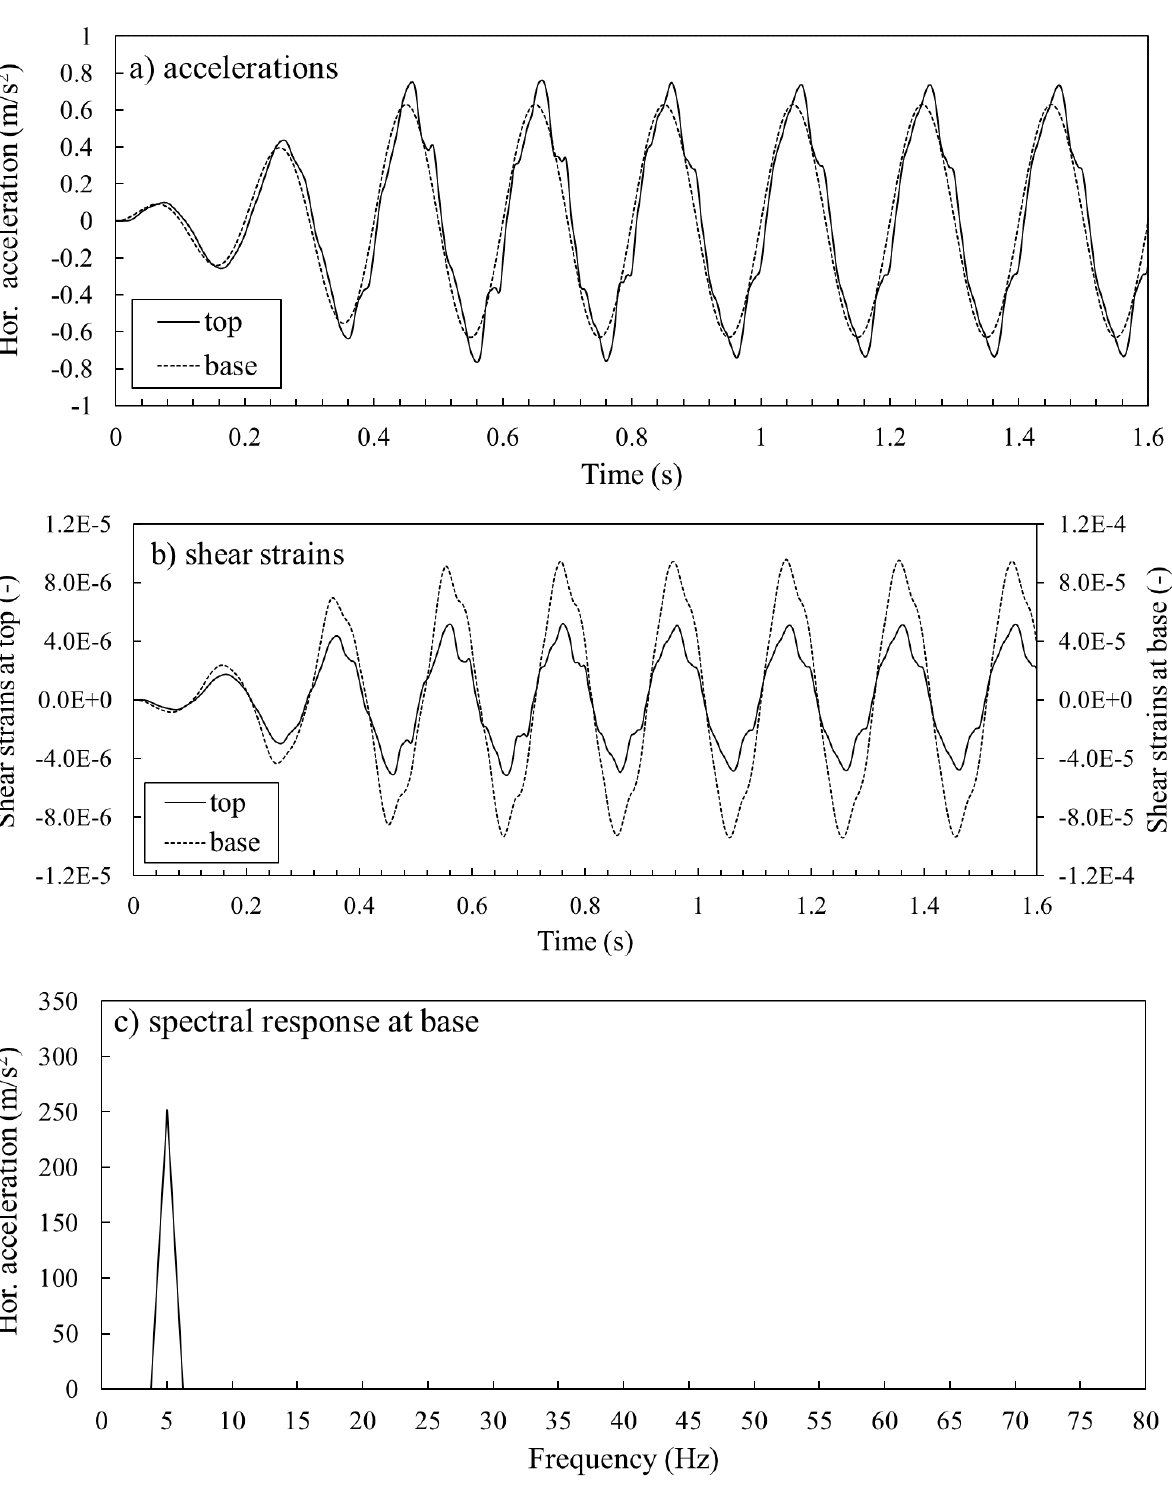
Figure 4: Free field response computed for the soil column with the chosen calibration of the hypoplastic sand model (Table 1): a) horizontal accelerations, b) shear strains, c) spectral response for horizontal accelerations at the soil base, d) spectral response for horizontal accelerations at the soil top, e) stress–strain